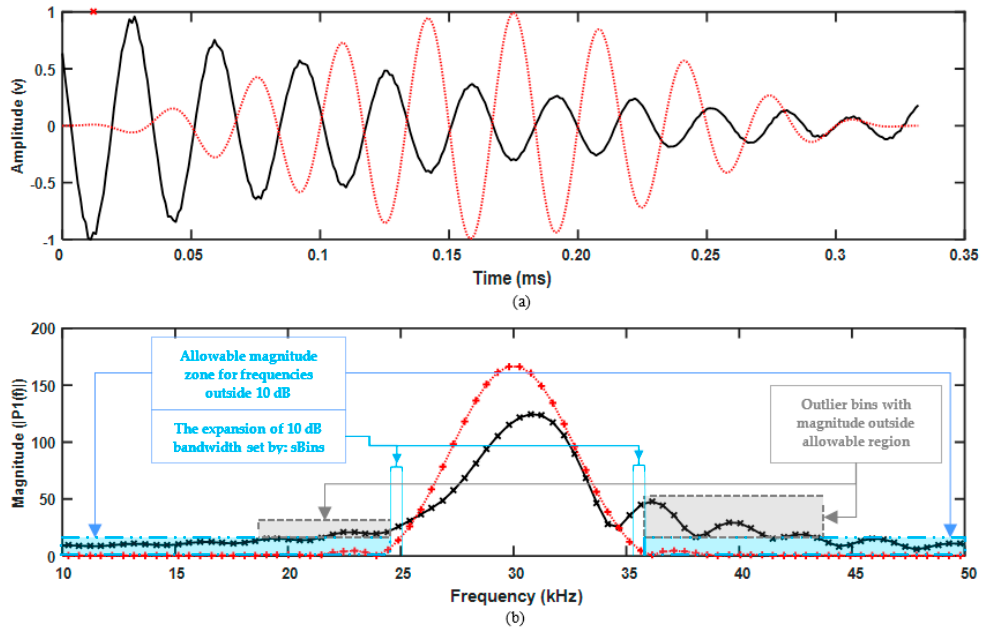
Figure 9. Example of an outlier case detected using Condition Three (C3), where ( a ) shows the time domain of the iteration window and ( b ) is its respective power spectrum. The red lines (dotted, +) show the references achieved from excitation sequence and the black lines (solid, x) show the results from each iteration.